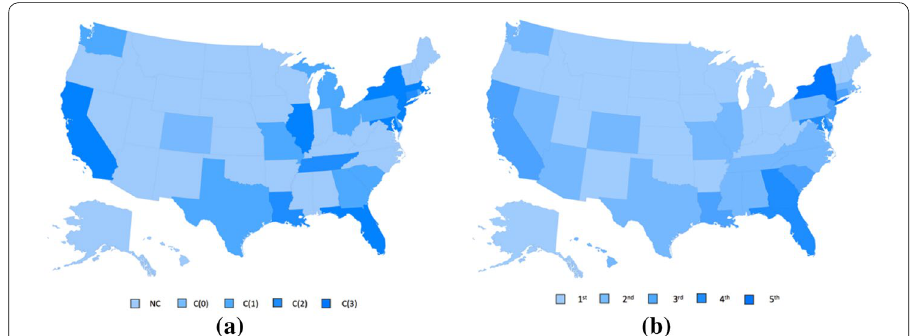
Fig. 10 US states categorized by ( a ) correlations-estimated models’ significance and ( b ) AIDS